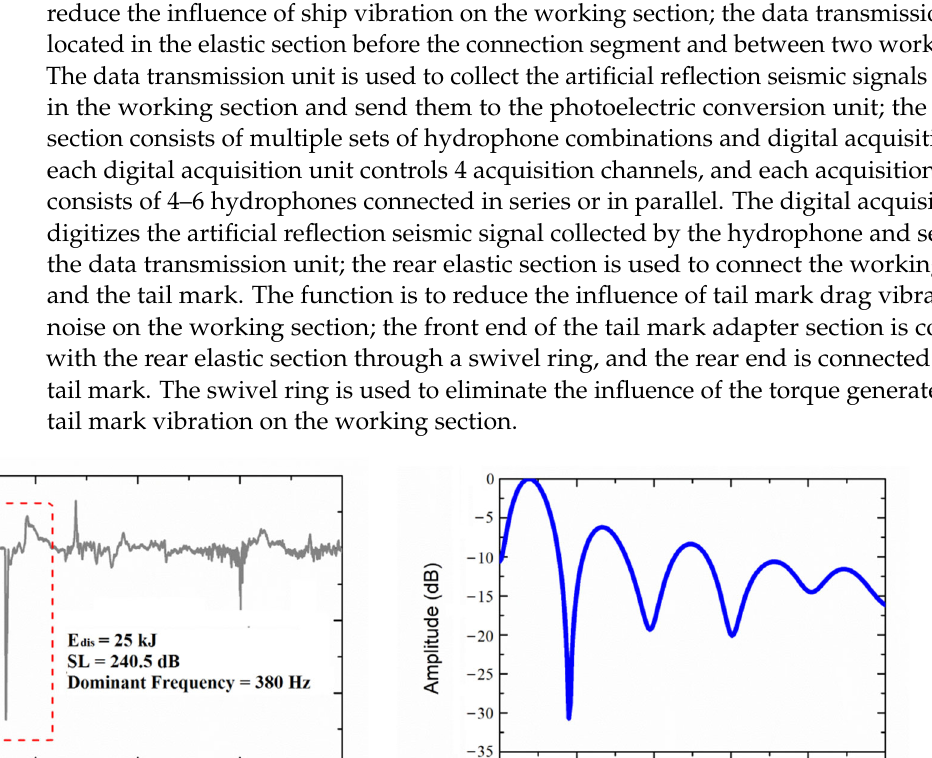
Figure 3. Plasma source array.